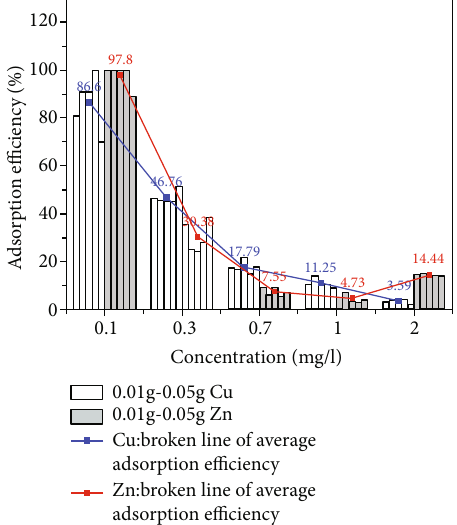
Figure 6: Adsorption e ffi ciency of microplastics to copper (Cu) and Zinc (Zn) ( V = 20 mL, temperature at 298K, t = 48